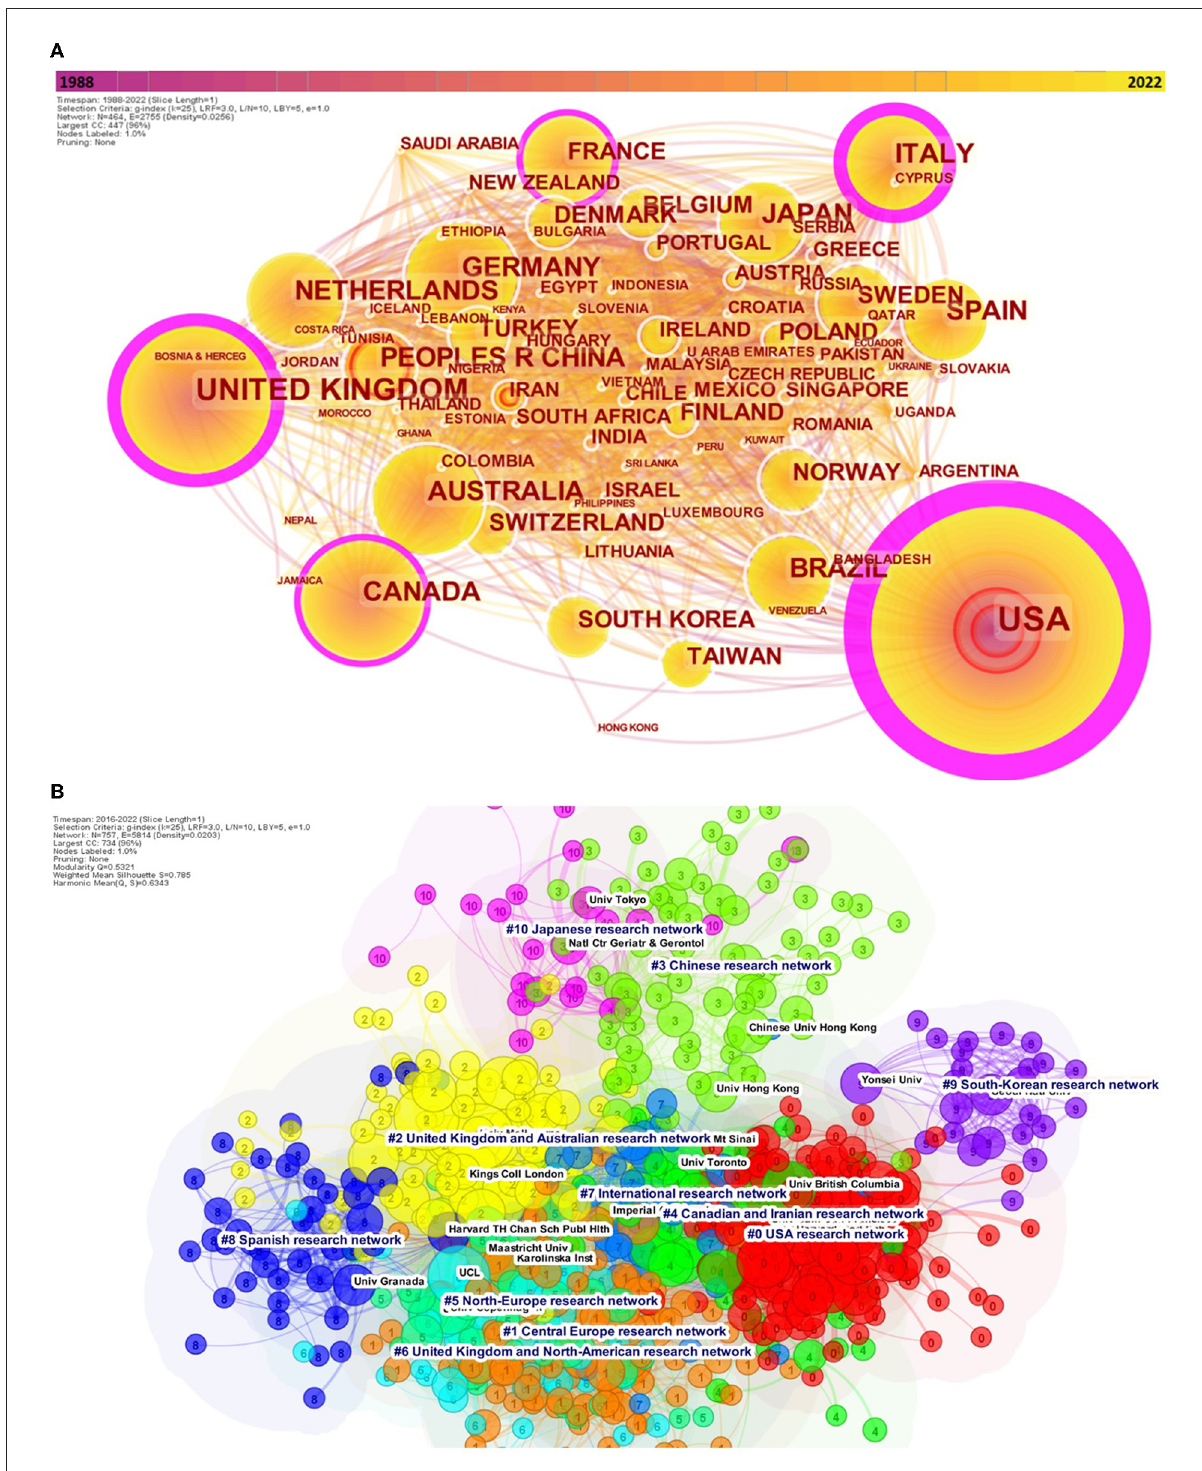
FIGURE3 Co-cited author’s countries (A) (1988–2021) and co-cited author’s institutions network with corresponding clusters (B) (2016–2021). Both the co-cited author’s countries and co-cited author’s institutions permits to reveal the collaborative country network. Betweenness centrality organize the network, with the countries presenting the most important centrality being at the center of the network. Nodes are according to each network, countries or institutions. The outermost purple ring denotes the centrality level, and highly central nodes are considered pivotal points in the research field. We limited the nodes to the 80 first